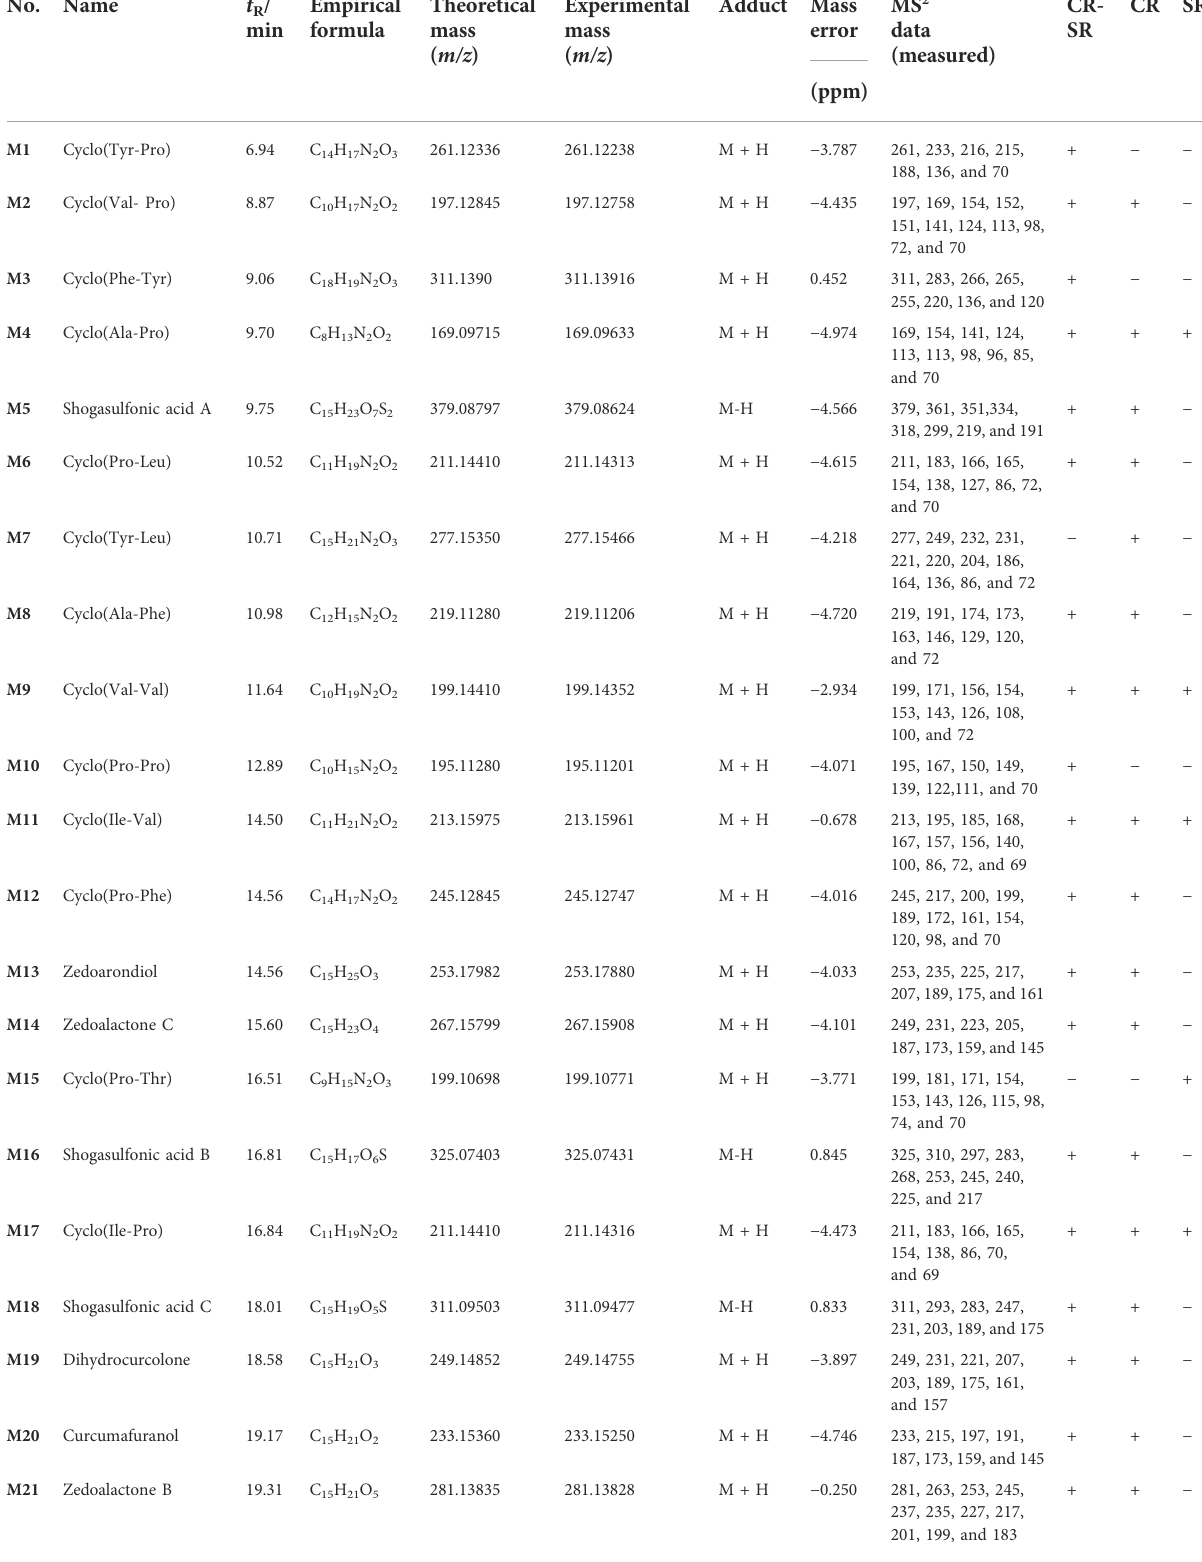
TABLE 3 Summary of components in CR-SR, CR, and SR